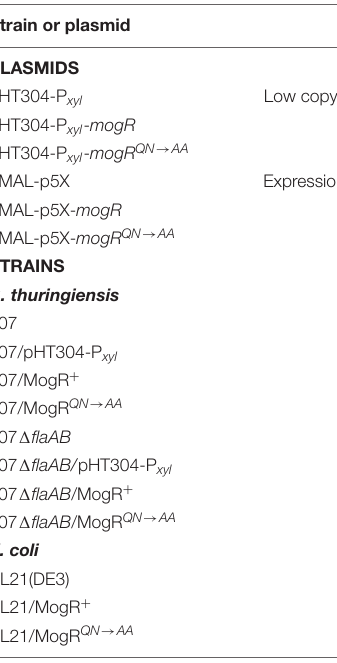
TABLE 1 | Strains and plasmids used in this